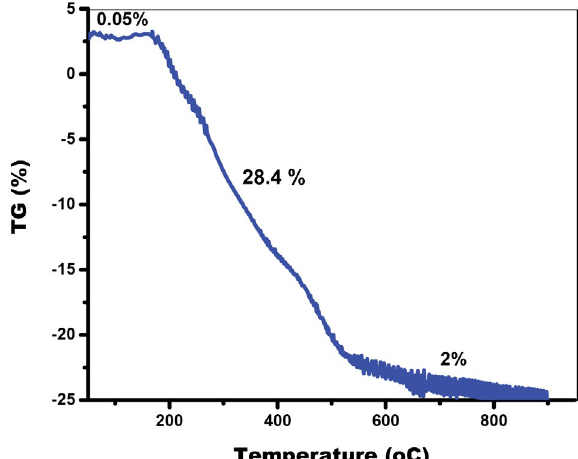
Fig. 2. TGA curve of CNT-Calix